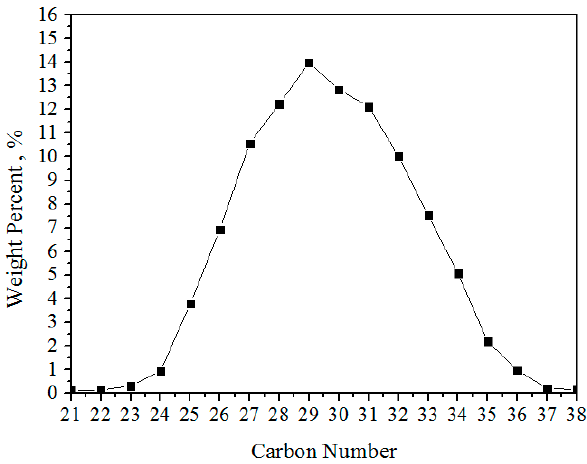
Figure 4. Carbon number distribution of wax.